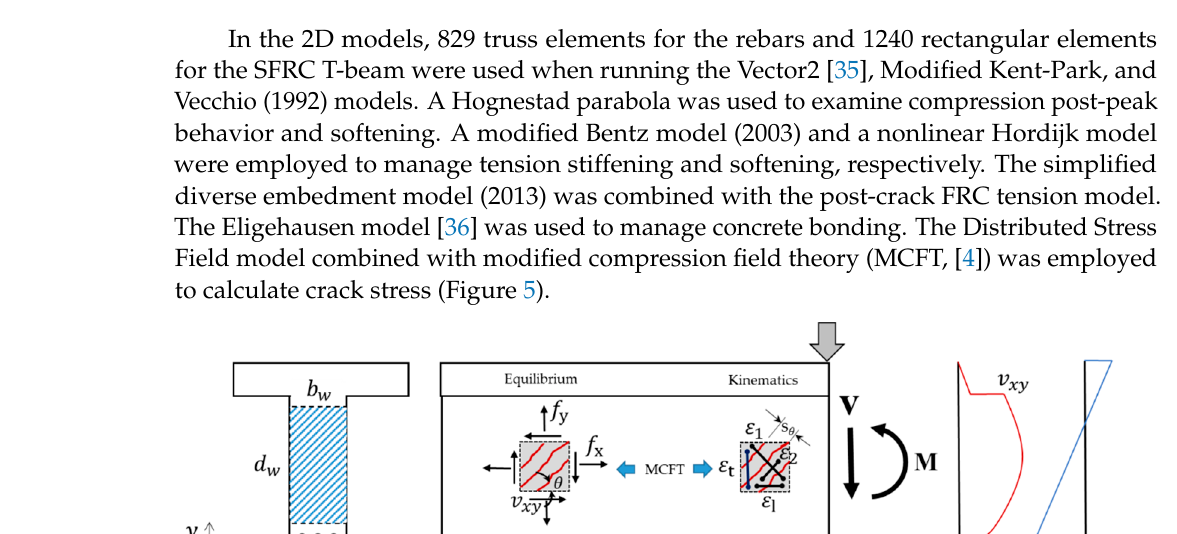
Figure 4. Compression and tension behaviors of SFRC. ( a ) Compressive softening. ( b ) Tension softening. ( c ) The P-CMOD for a single-notched SFRC beam.